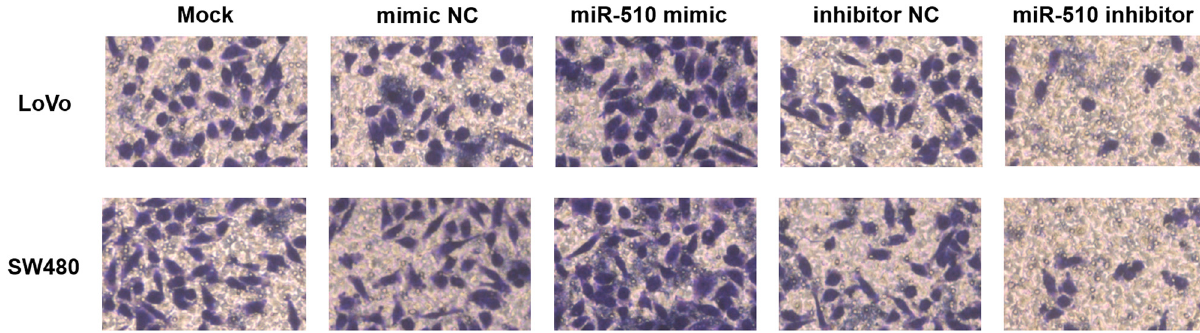
Figure A1: Representative images of the migration of LoVo and SW480 cells by the Transwell assay.